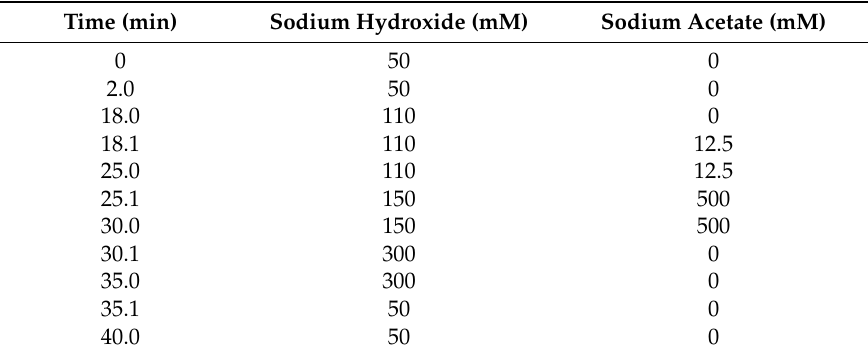
Table 4. Gradient for determination of 2 (cid:48) -FL and LNnT by HPAEC-PAD. Time (min) Sodium Hydroxide